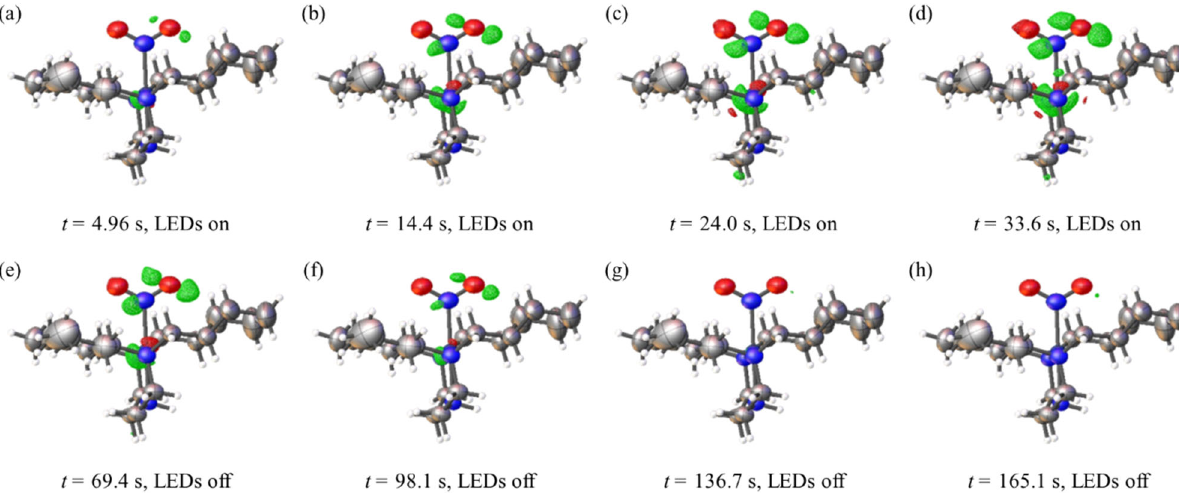
Fig. 4 Selected photo-difference maps illustrating the change in electron density in 1 during photoexcitation and decay at 265 K. Fourier electron- density difference maps calculated between the fi xed GS coordinates and the ES structure data (ellipsoids shown at 50% probability). Green and red contours show regions of density accumulation and depletion, respectively. a – d are from structures recorded during the LED illumination period t exc , while e – h are from structures recorded during the ES decay period t dec . All photo-difference maps are set to a consistent level of ± 0.8 e A − 3 per contour for comparable images, with maximum and minimum electron density levels in each image as follows (in e A − 3 ): a min = − 0.901, max = 1.729; b min = − 2.023, max = 2.864; c min = − 2.511, max = 4.087; d min = − 2.838, max = 5.249; e min = − 2.230, max = 3.657; f min = − 0.975, max = 1.682; g min = − 0.670, max = 0.783; h min = − 0.666, max =